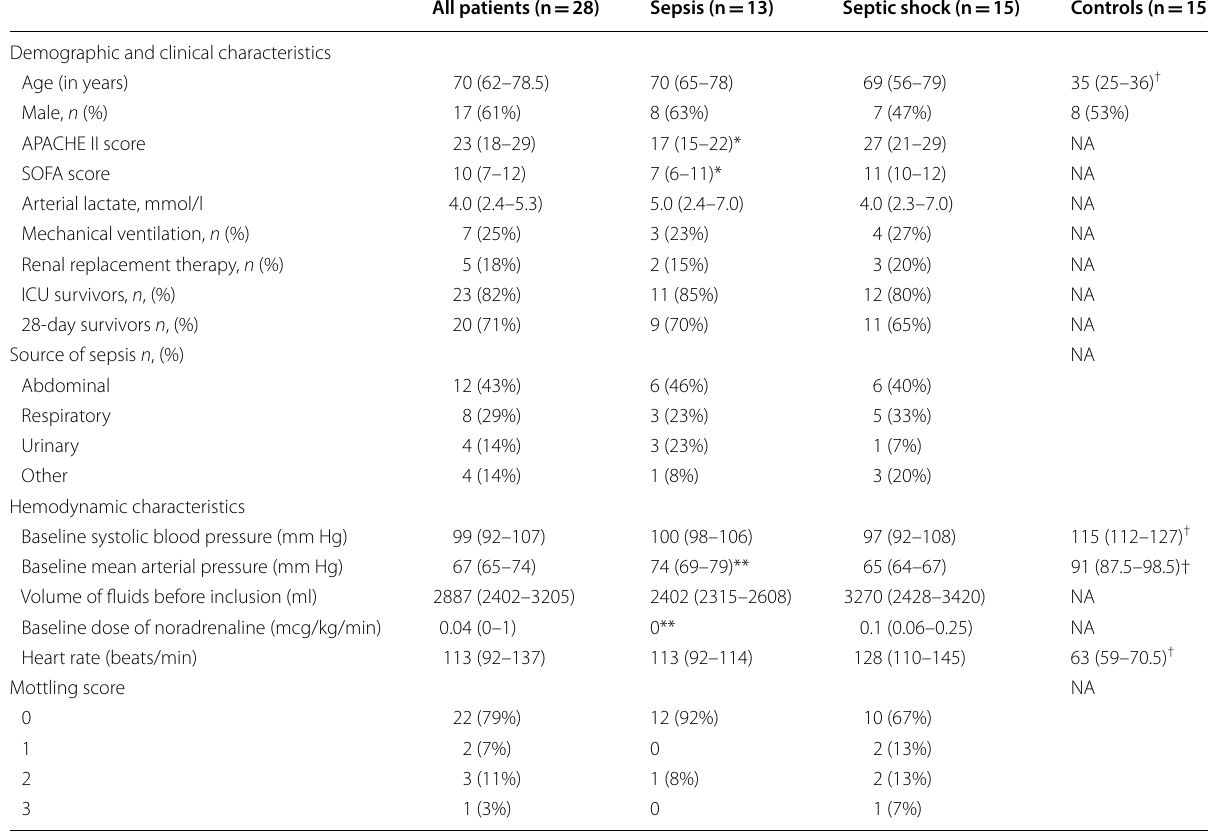
Data are presented as numbers with percentages (%) or medians with interquartile range APACHE II, Acute Physiology, Age, Chronic Health Evaluation II; Sequential Organ Failure Assessment (SOFA) score represents maximum value calculated within 24 h of intensive care unit